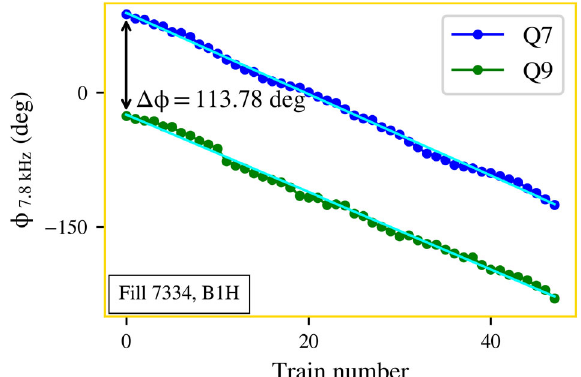
FIG. 8. The phase evolution of the h ¼ 156 harmonic as a function of the train number for Q7 (blue) and Q9 (green). The cyan lines illustrate the expected phase evolution of the harmon- ics in the accelerator (Appendix